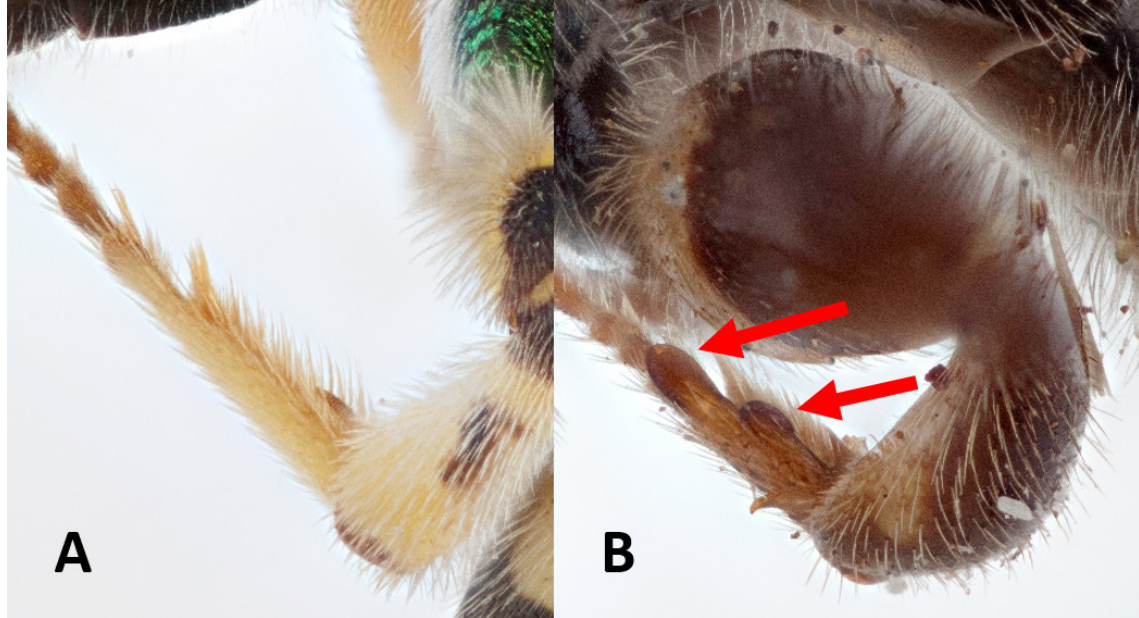
Fig. 10. Hind basitarsus of male. A . Agapostemon virescens (Fabricius, 1775), which is unmodified. B . Ag. femoralis (Guérin-Méneville, 1844), with upper arrow showing the prominent apical groove, and the lower arrow showing the prominent basal